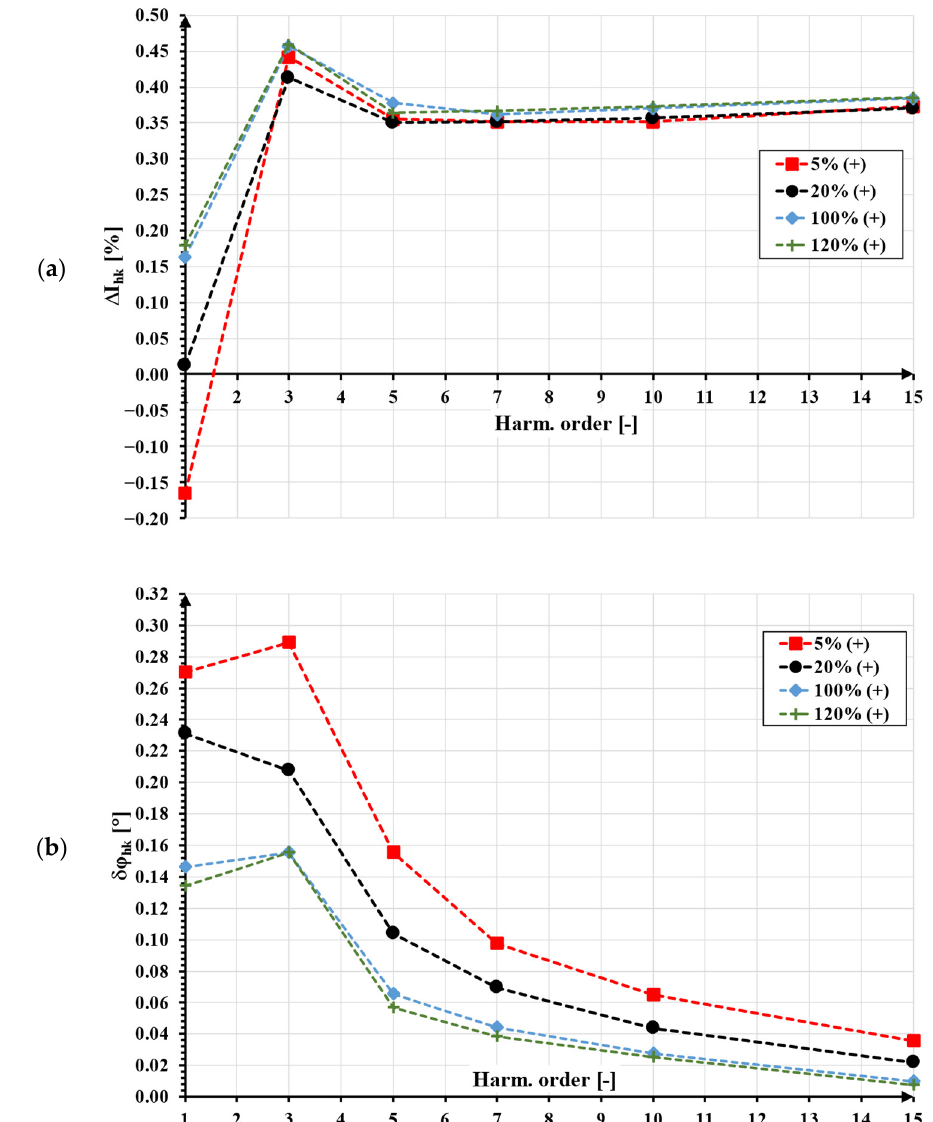
Figure 6. The highest absolute values of ( a ) current error and ( b ) phase displacement determined for inductive CT 300 A/5 A with 25% of the rated resistive load of the secondary winding